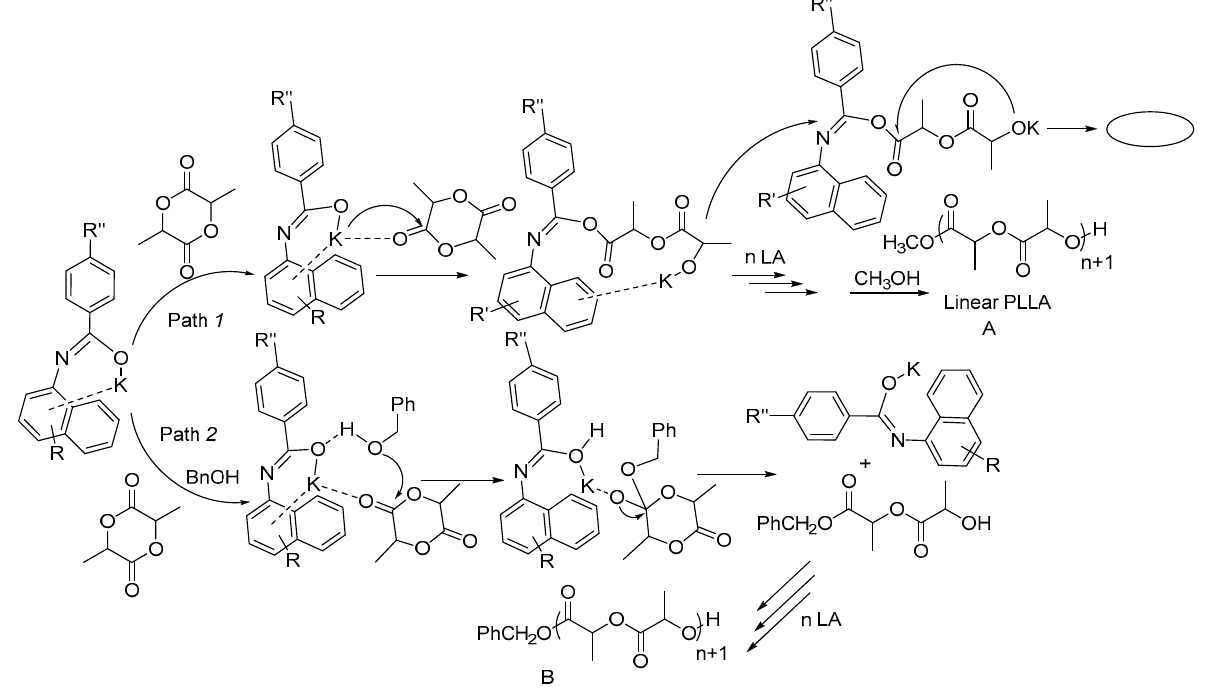
Catalysts 2023 , 13 , x FOR PEER REVIEW 10 of Figure 6. MALDI-TOF spectrum of PLLA prepared by K2 and 10 equivalent BnOH (run 9, Table 2).